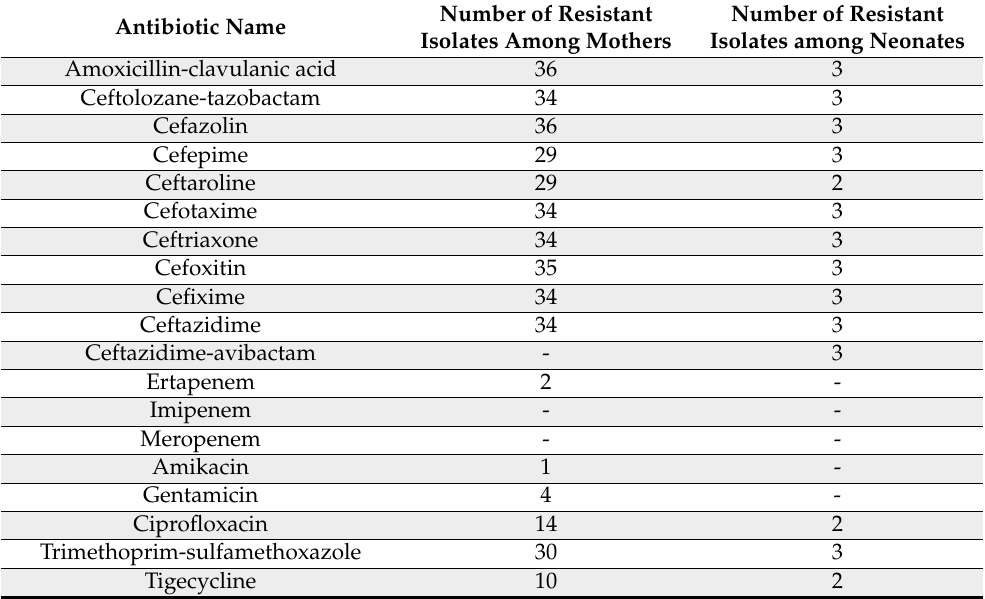
Table 4. The number of resistant isolates to each antibiotic among mothers and